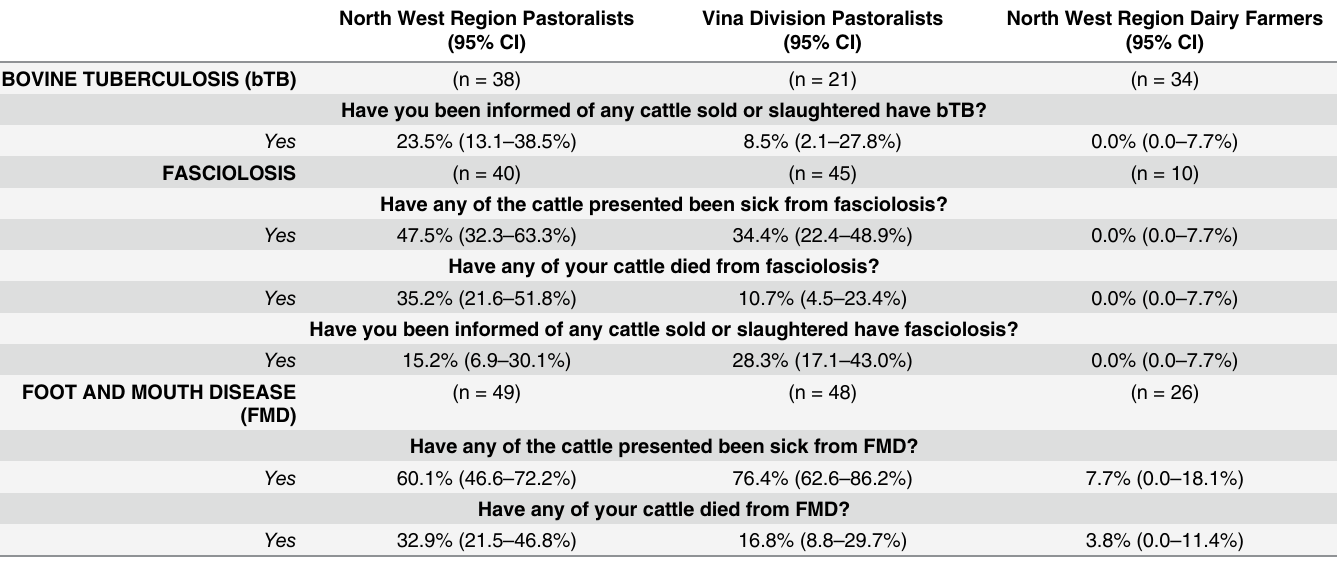
Table 1. Proportion of herds reported to have had various infectious diseases based on the subset of pastoralist and dairy farmers who reported being aware of the given infectious disease. North West Region Pastoralists Vina Division Pastoralists (95% CI) (95% CI) BOVINE TUBERCULOSIS